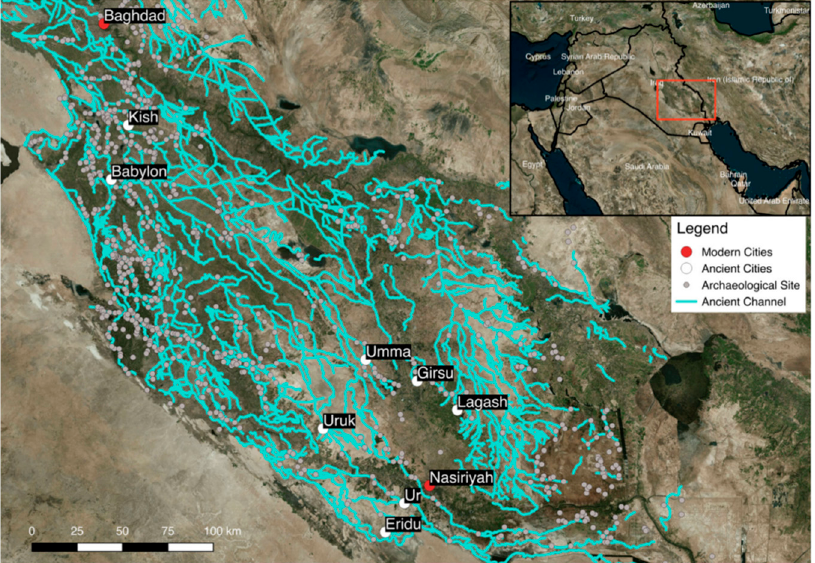
Figure 1. Map of southern Iraq, showing ancient sites and channels, along with major ancient cities. All information are taken from [4].